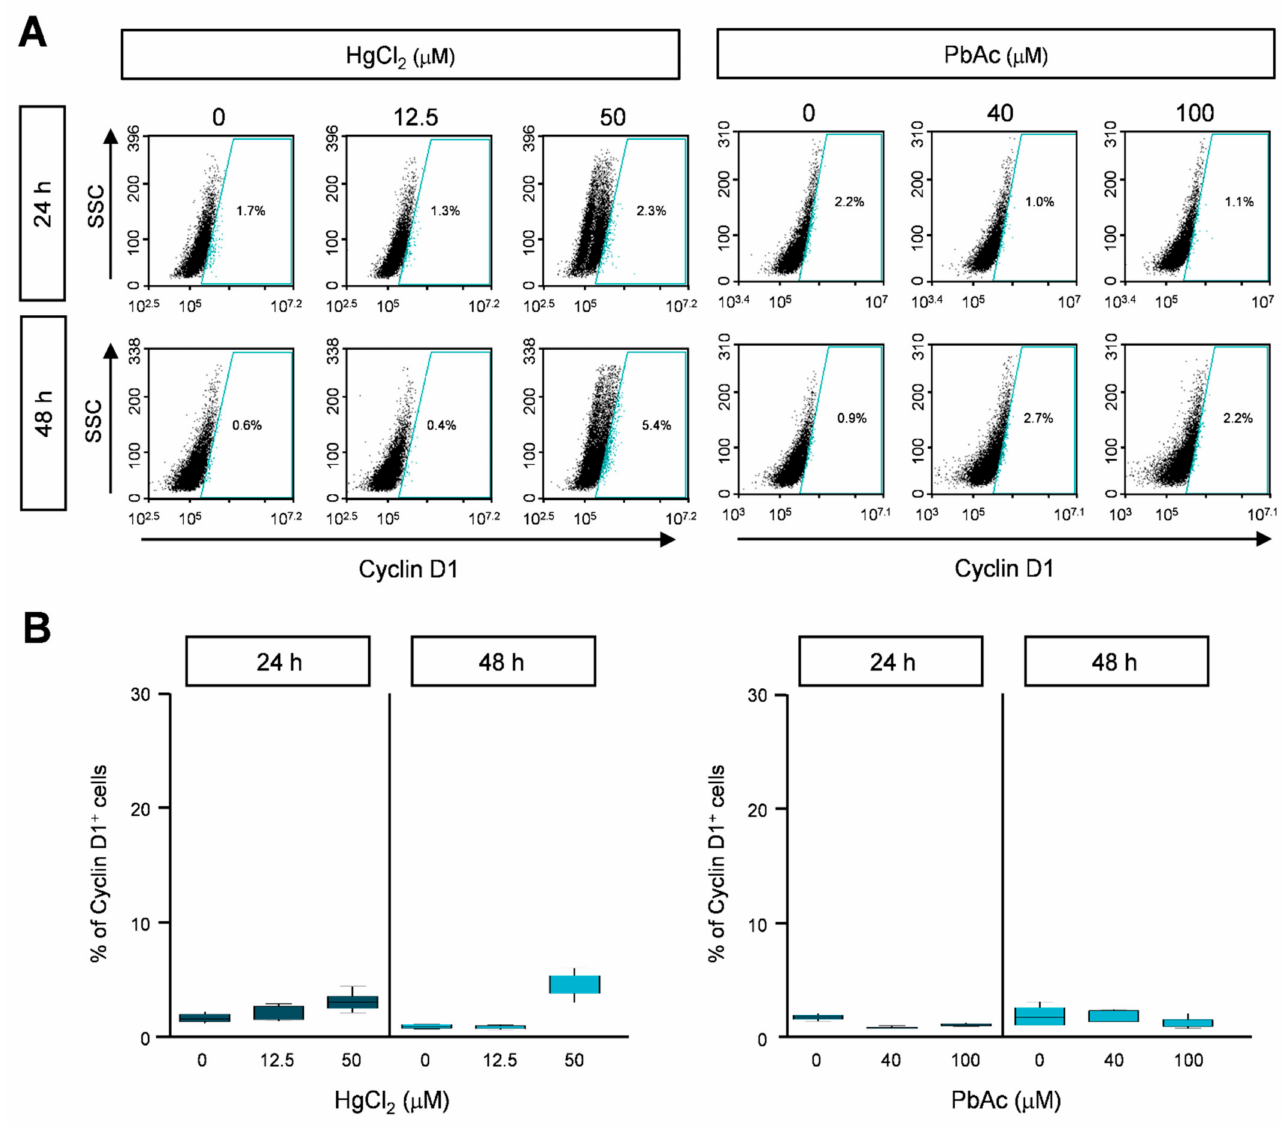
Figure 5. The effect of heavy metals on cyclin D1 expression in MRC5 cells. ( A ) Cells were treated with indicated concentration of heavy metals for 24 or 48 h. Cells were fixed with 1% PFA and stained with anti-cyclin D1 antibody. The cyclin D1 expression was analyzed by FACS analysis. ( B ) The percentages of cyclin D1-positive cells are represented as the mean ± S.E.M. of three independent experiments (n = 6), each performed in triplicate. EtOH was used as the negative